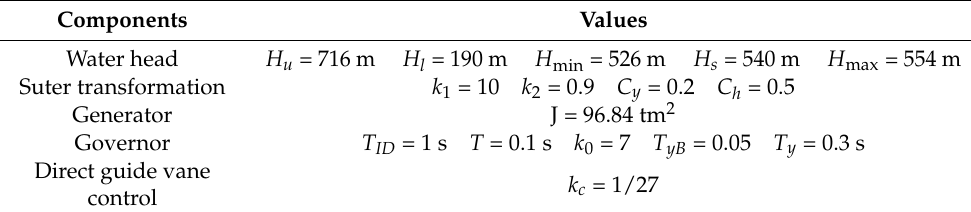
Table 2. The physical parameters and working-condition parameters of the model.